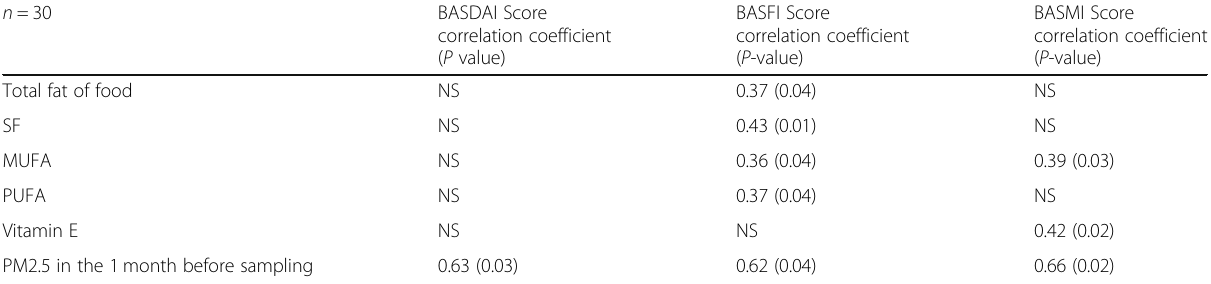
Table 6 Correlations between disease activity and environmental factors in AS patients n = 30